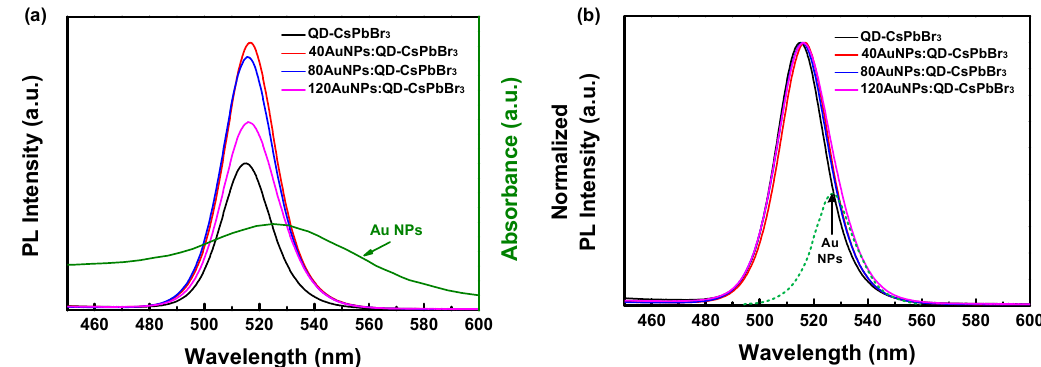
Figure 5. ( a ) Photoluminescence (PL) spectra and ( b ) normalized PL spectra of